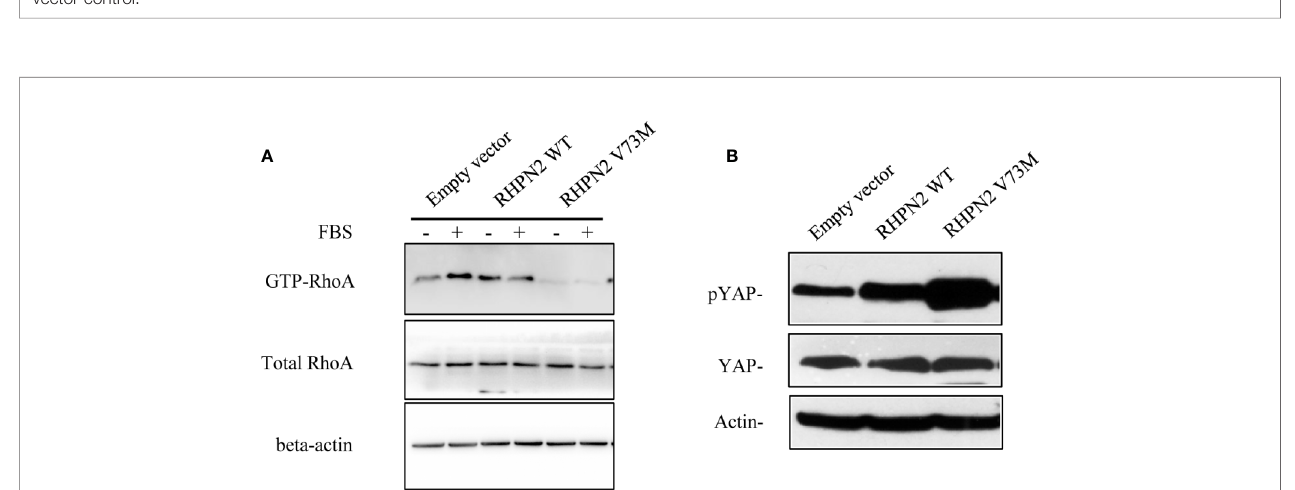
FIGURE 3 | RHPN2 promotes growth of lung cancer cells in vivo . (A) The expression of FLAG-tagged RHPN2 in A549 cells was determined by Western Blotting using anti-FLAG antibody. (B) The tumors formed in nude mice injected by A549 cells expressing FLAG-RHPN2 and empty vector. (C, D) Quantitative results of tumor weight (C) and tumor volume (D) . Tumor volume was measured three times every week. The data were shown as mean ± SD. ** p < 0.01 compared with vector control.